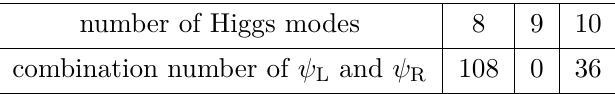
Table 25 . D L = D R = 4 , D H = 16 .